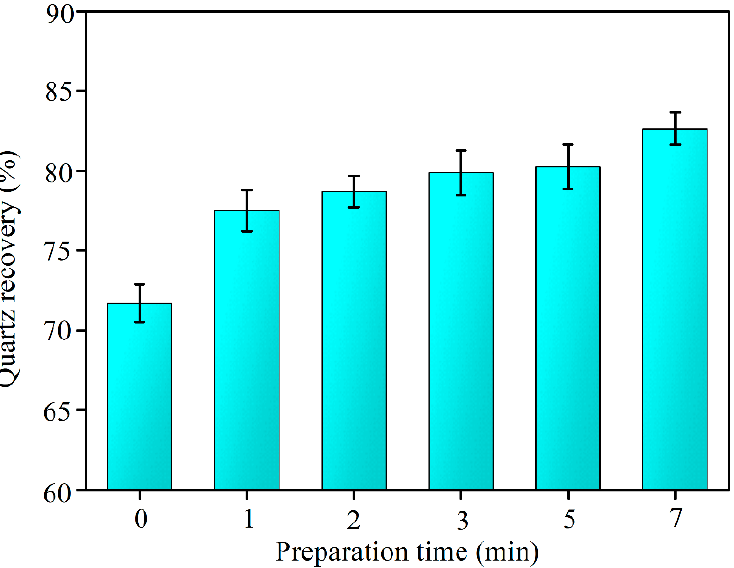
Figure 14. Effect of preparation time of BMNBs water on quartz recovery (aeration rate 0.5 L/min).